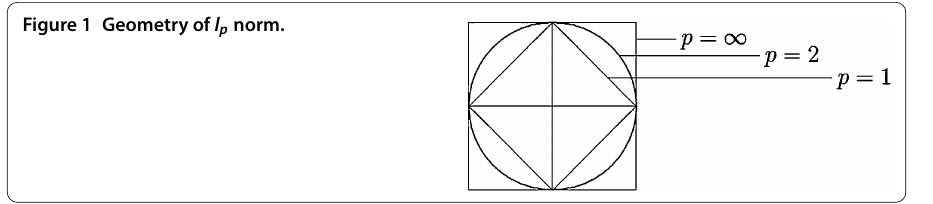
Figure 1 Geometry of l p